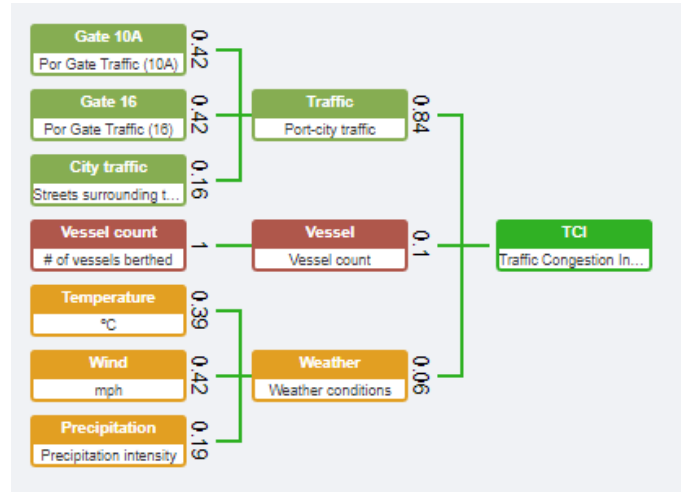
Figure 13. Tree definition and weighting for calculating the Traffic Congestion Index.